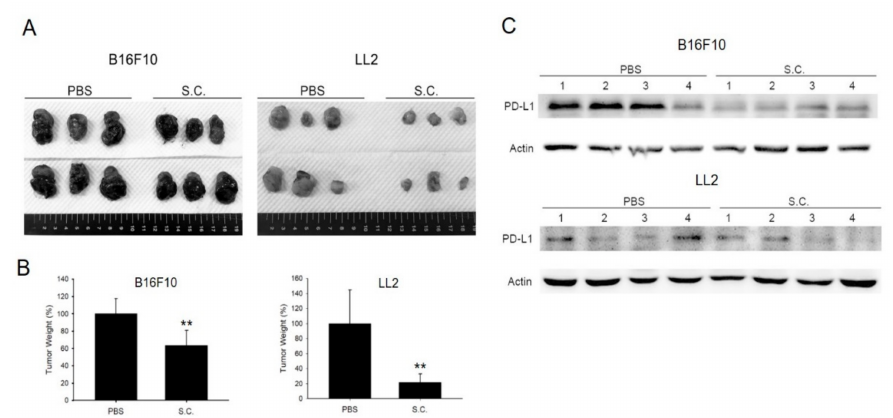
Figure 5. Salmonella (S.C.) inhibited tumor growth in vivo and enhanced T cells infiltration by downregulating programmed death-ligand 1 (PD-L1). ( A ) Tumor tissue size was observed and ( B ) measured on day 15 and 21 for B16F10 ( n = 6) and LL2 ( n = 6), respectively. **, p < 0.01. ( C ) PD-L1 expression of B16F10 and LL2 tumors were analyzed by Western blotting. Each group was repeated four times.